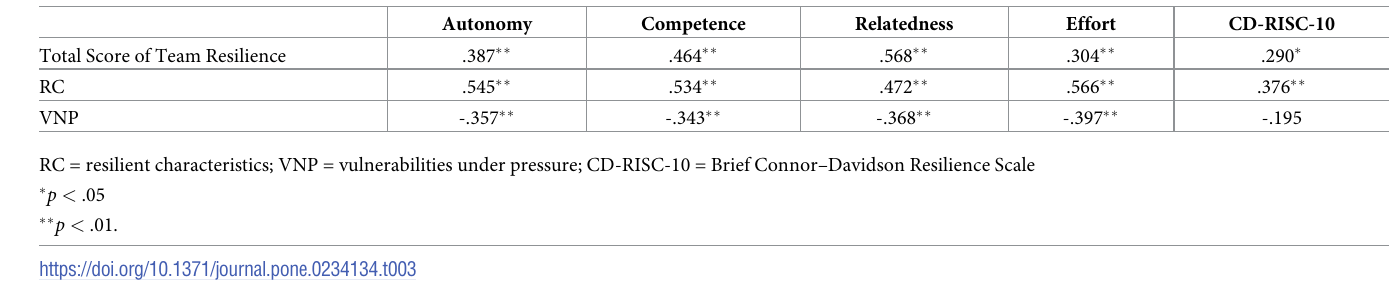
Table 3. Correlations between CREST, its two structures and theoretically relevant